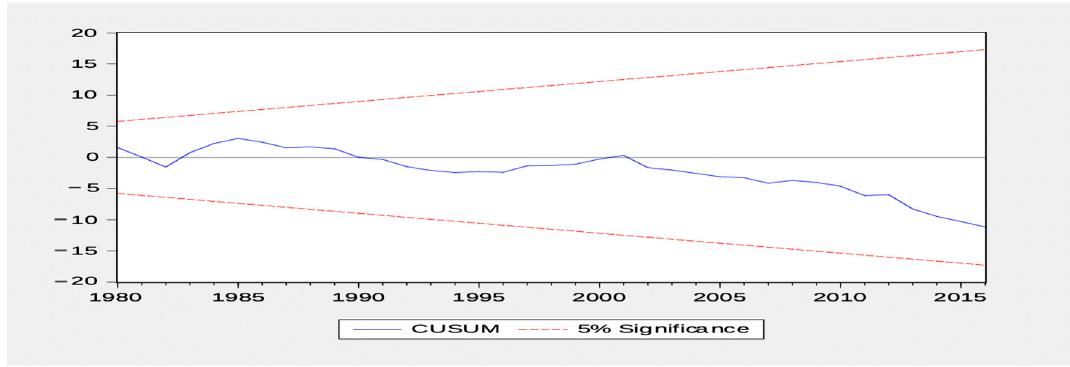
Figure A7. Square of CUSUM Test (Saudi Arabia).